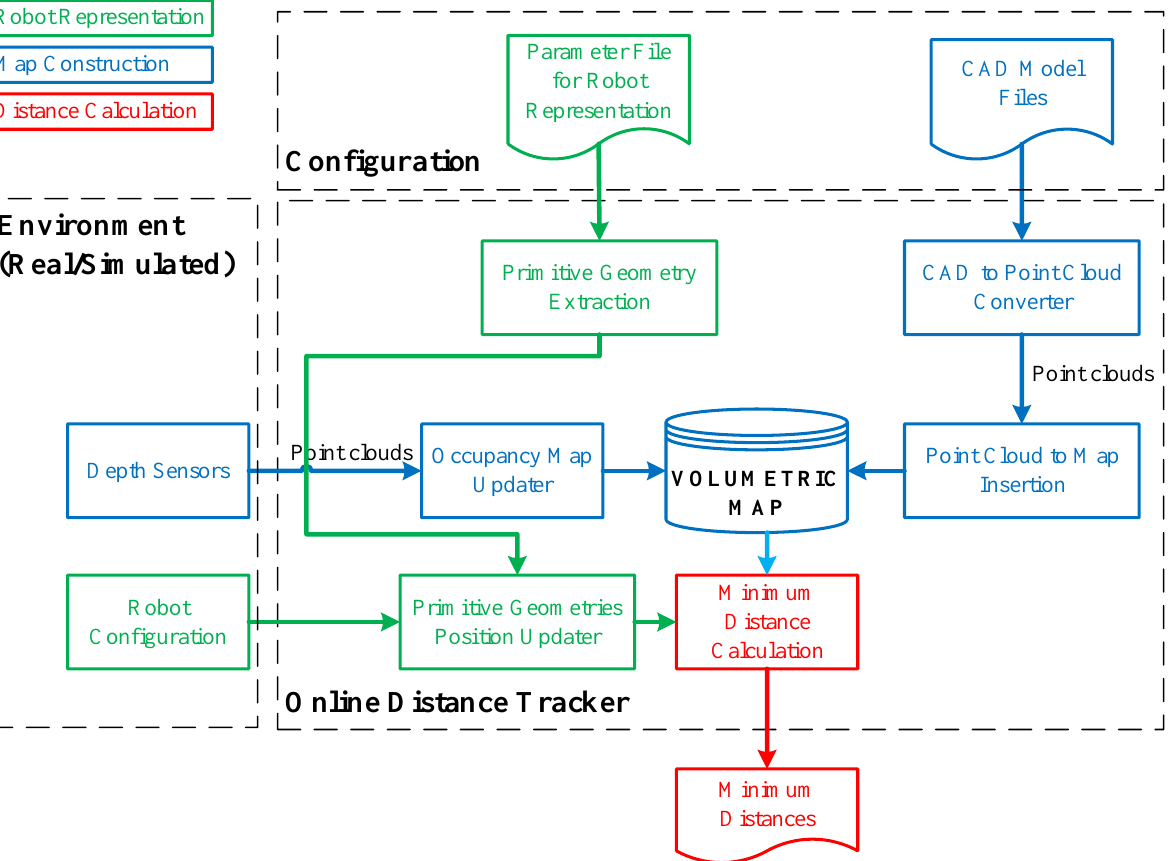
Figure 1. The architecture of the online distance tracker.